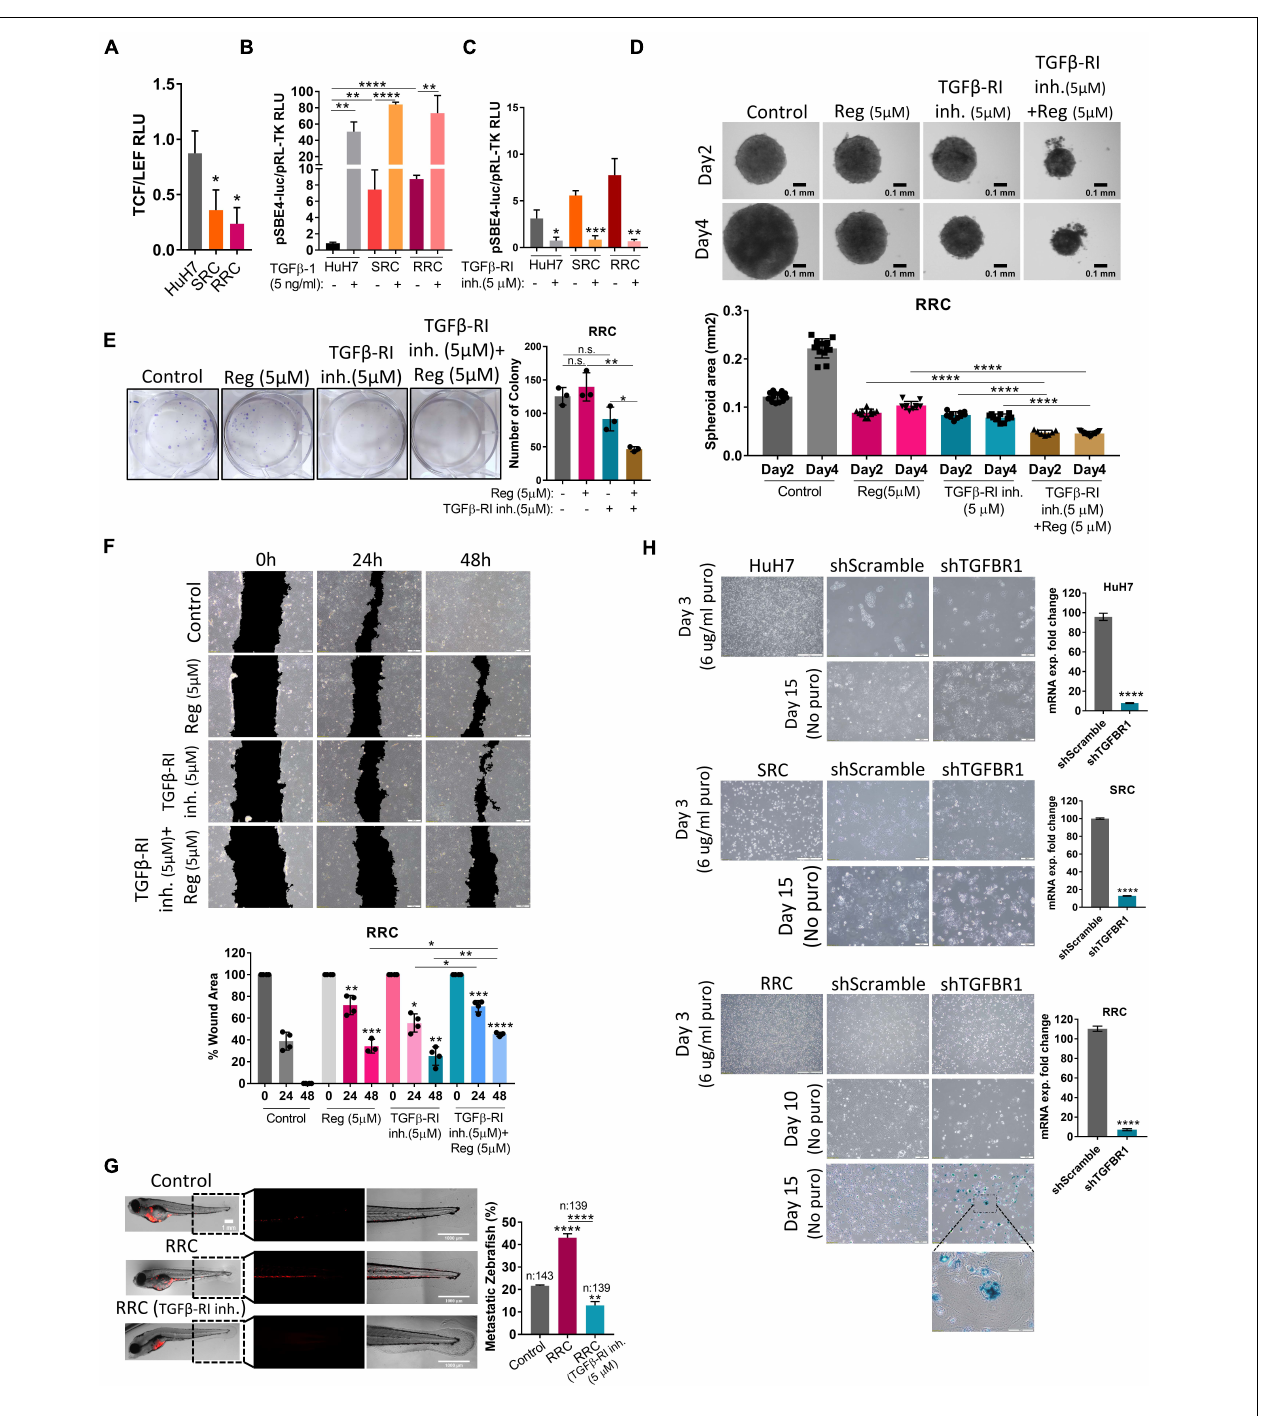
FIGURE 6 | The augmented migration capacity of regorafenib resistant cells is mediated by the TGF- β pathway. (A) TCF/LEF reporter assay of resistant cells exhibit decreased TCF/LEF reporter activity. (B) TGF- β pathway activity was detected in HuH7, SRC and RRC cell lines after treatment with TGF- β 1 or (C) TGF β -RI inhibitor using pSBE4-Luc/pRL-TK reporter plasmid. (D) 3-D spheroids were formed from RRC cells with or without regorafenib and TGF β -R1 treatment. Spheroid area was calculated using ImageJ. (E) Colony formation and (F) Scratch assay was performed in RRC cells with or without regorafenib and TGF β -R1 treatment. Wound area was calculated using ImageJ MRI wound healing tool. (G) HuH7 cells, untreated RRC cells and TGF β -R1 inhibitor treated RRC cells were implanted into the yolk sac of 2 dpf zebrafish embryos. 5 days after injection, migration to the tail was quantified. Representative images of zebrafish embryos were acquired on a Carl Zeiss LSM 880 AxioObserver confocal microscope with an EC Plan-Neofluar 10x/0.30 M27 objective. (H) SA- β -gal staining of control and TGF β -R1 knocked down HuH7, SRC and RRC cells. p > 0.05 (n.s.), p ≤ 0.05 (*), p ≤ 0.01 (**), p ≤ 0.001 (***), p ≤ 0.0001 (****). Error bars indicate standard deviation (SD).